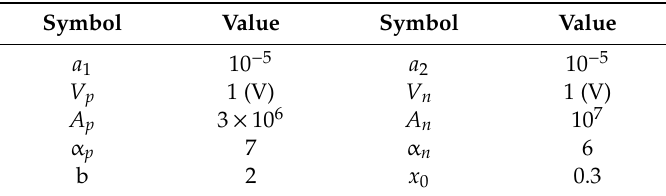
Table 1. Model parameters used in the memristor